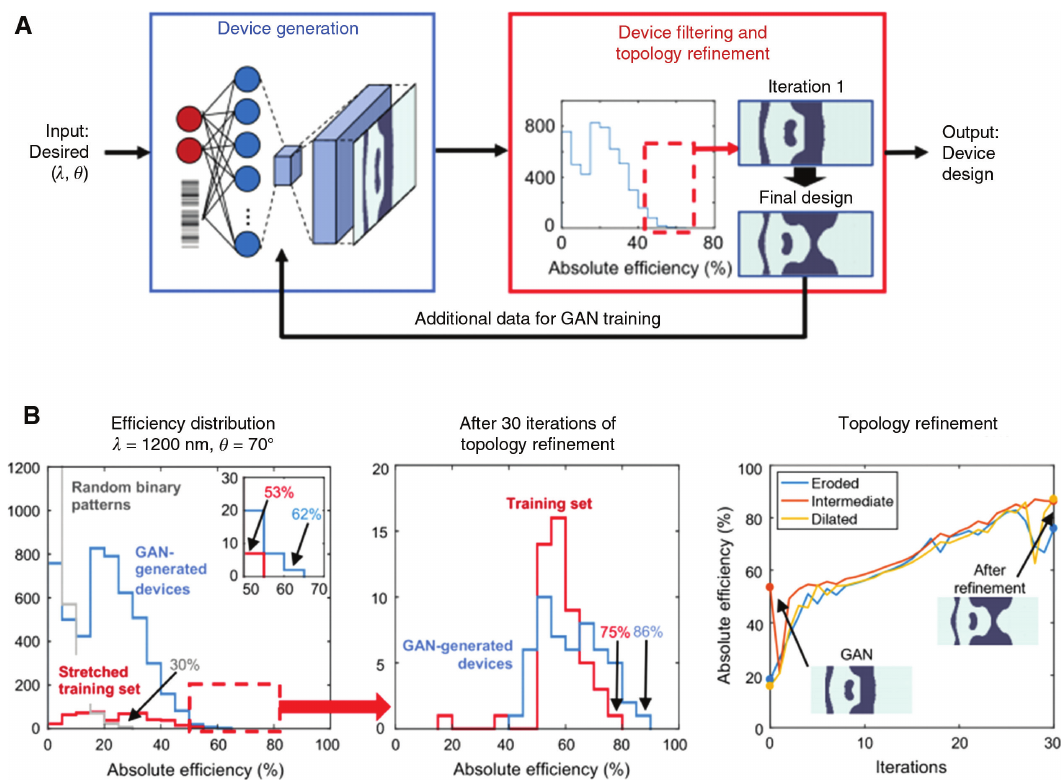
Figure 6: DL-assisted inverse design method combined with topology optimization. (A) A schematic of the inverse design where a GAN generates training data. The generated designs are further optimized using topology optimization. (B) Metagrating generation and their topology optimization results. Efficiency histogram of the randomly generated pattern (left) and the refined pattern (middle), and the diffraction efficiency changes with the iterations (right). (A) and (B) are reprinted with permission from Ref. [73], Copyright 2019 American Chemical